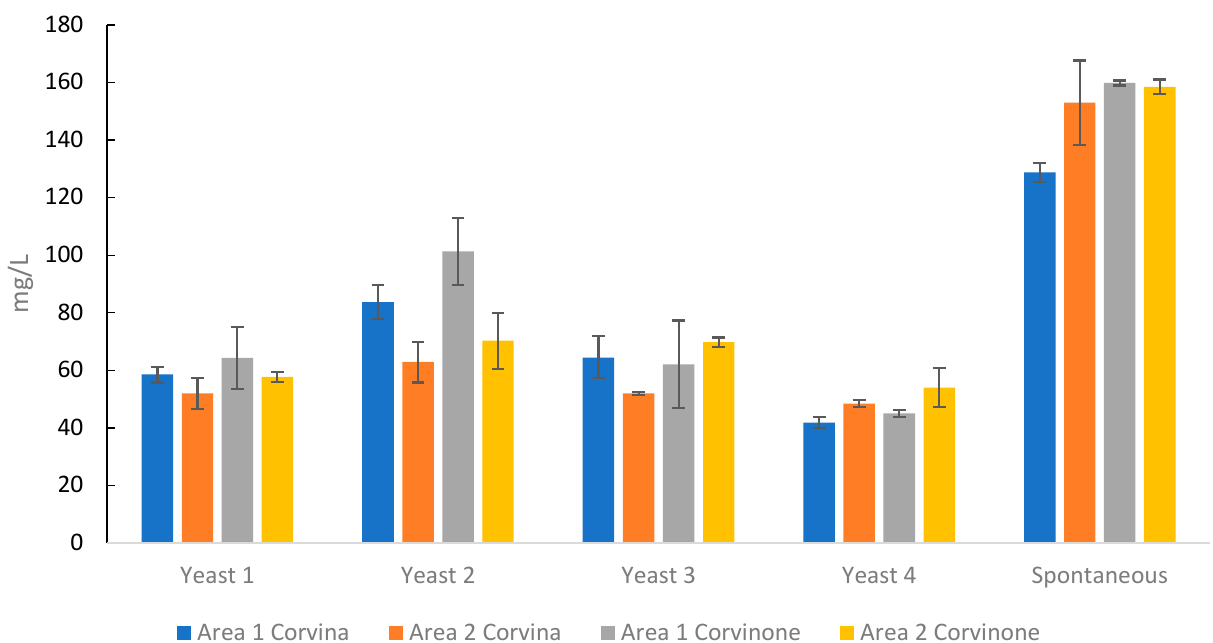
Figure 3. Concentration of ethyl acetate in wines obtained with different commercial strains as well as by spontaneous fermentation. Error bars indicate ± standard deviation.